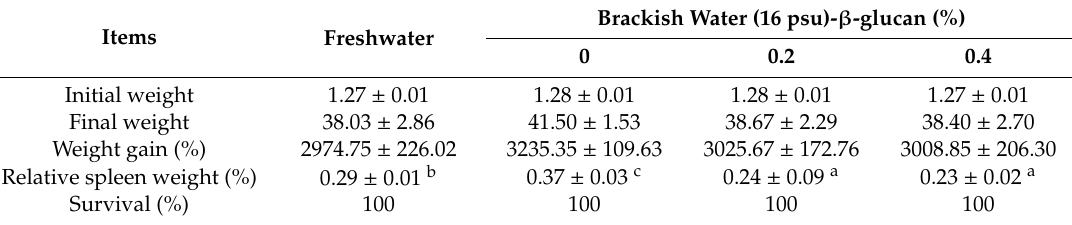
Table 3. Growth performance, survival, and relative spleen weight of Oreochromis niloticus fed diets with di ff erent β -glucan percentages under two salinities for 8 weeks. Brackish Water (16 psu)- β -glucan (%) Items Freshwater